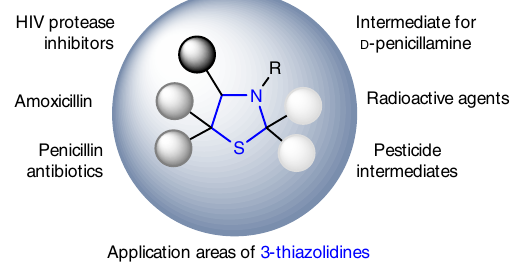
Fig. 1 Application areas of 3-thiazolidines. Examples for pharmaceutical relevant structures containing 3-thiazolidines as structural